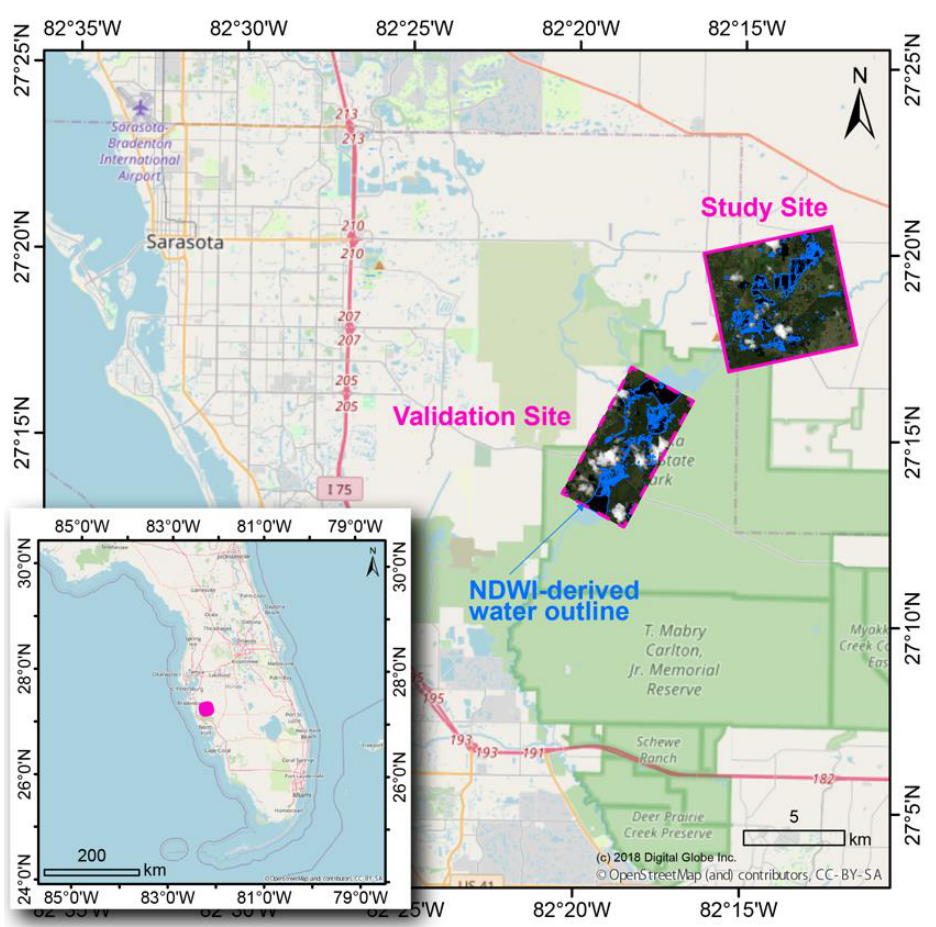
Figure 1. Location of the study site with a validation site shown as pink rectangles. Basemap is derived from OpenStreetMap.